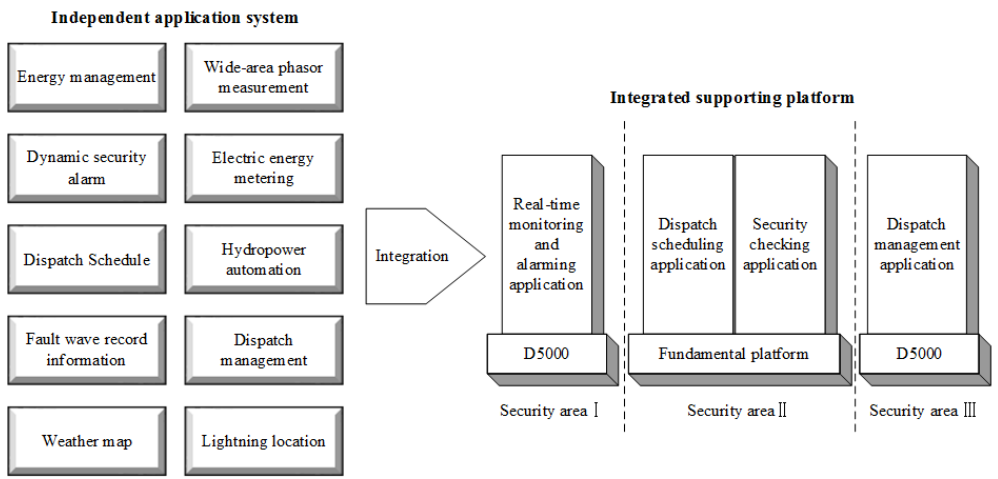
Figure 1. Schematic diagram of horizontal integration of the dispatch system in China. The vertical connection of the dispatch system can be shown in Figure 2. The na-